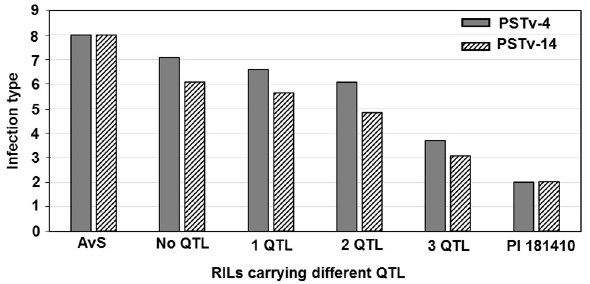
Figure 5. Comparison of mean infection type values of recombinant inbred lines (RILs) derived from cross AvS × PI 181410 containing different all-stage resistance QTL combination.